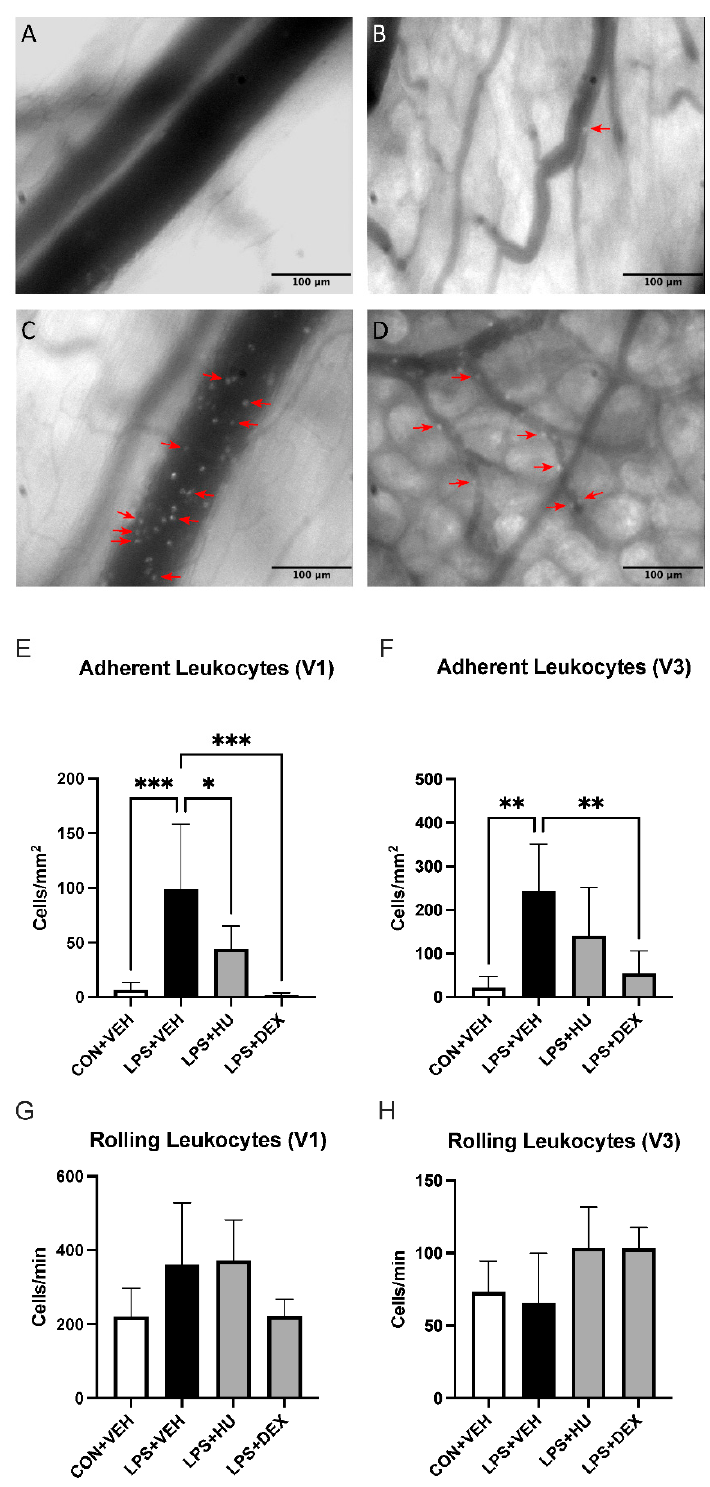
Figure 4. Impact of LPS and treatment on intestinal leukocyte activation. Representative images of ileal submucosal ( A ) V1 and ( B ) V3 venules in con + veh mice, and ( C , D ) lps + veh mice. Red arrows denote adherent leukocytes. Analysis of leukocyte adhesion in ( E ) V1 and ( F ) V3 venules. Analysis of leukocyte rolling in ( G ) V1 and ( H ) V3 venules. Data are expressed as mean ± SD. Statistically significant differences were determined via one-way ANOVA with Dunnett’s multiple comparisons test and are depicted as * p ≤ 0.05, ** p ≤ 0.01, *** p ≤ 0.001.